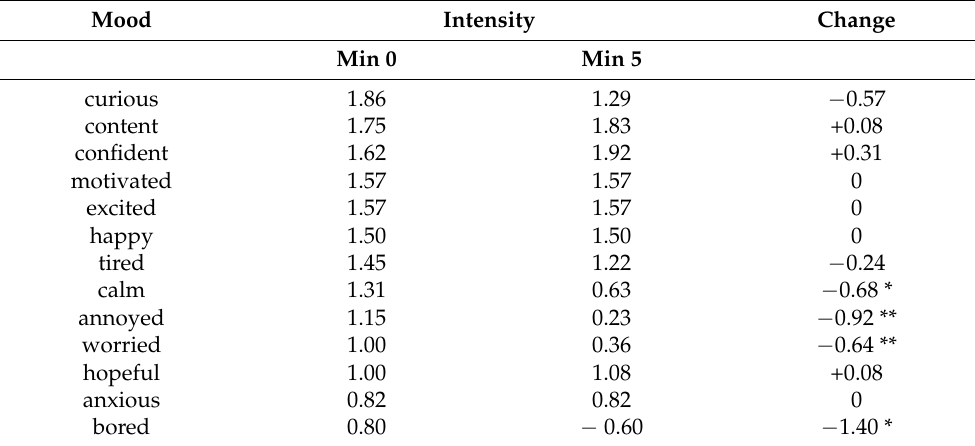
Table 4. Initial and final intensity ratings of individual moods during the music episodes. Mood